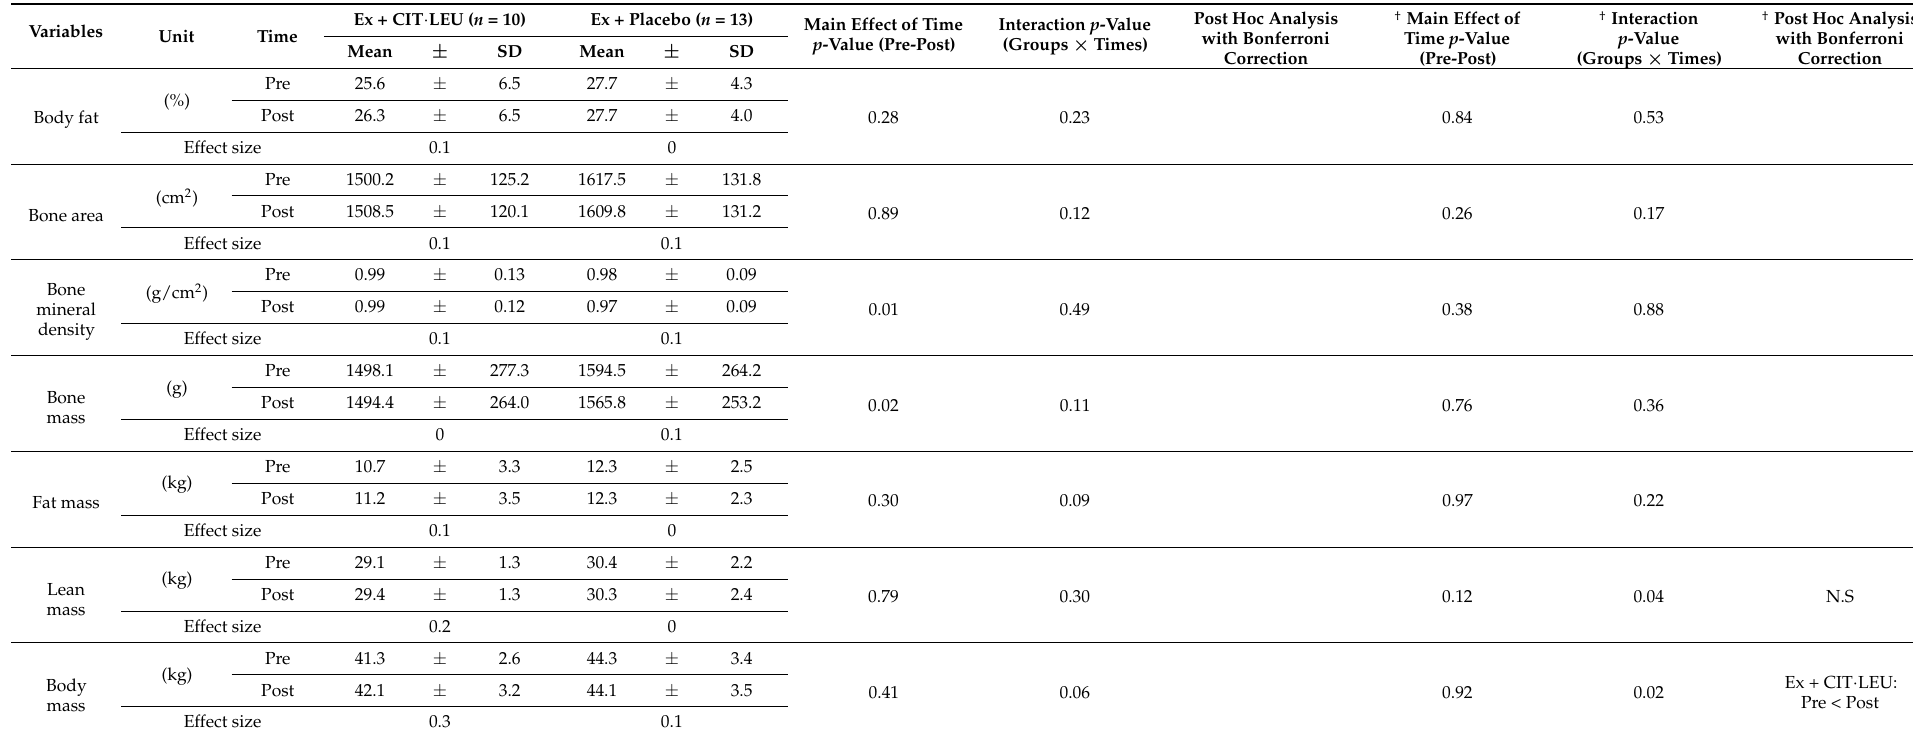
Table 3. Effects of amino acids (CIT and LEU) intake and multicomponent exercises on body compositions (Variables measured in Pre and